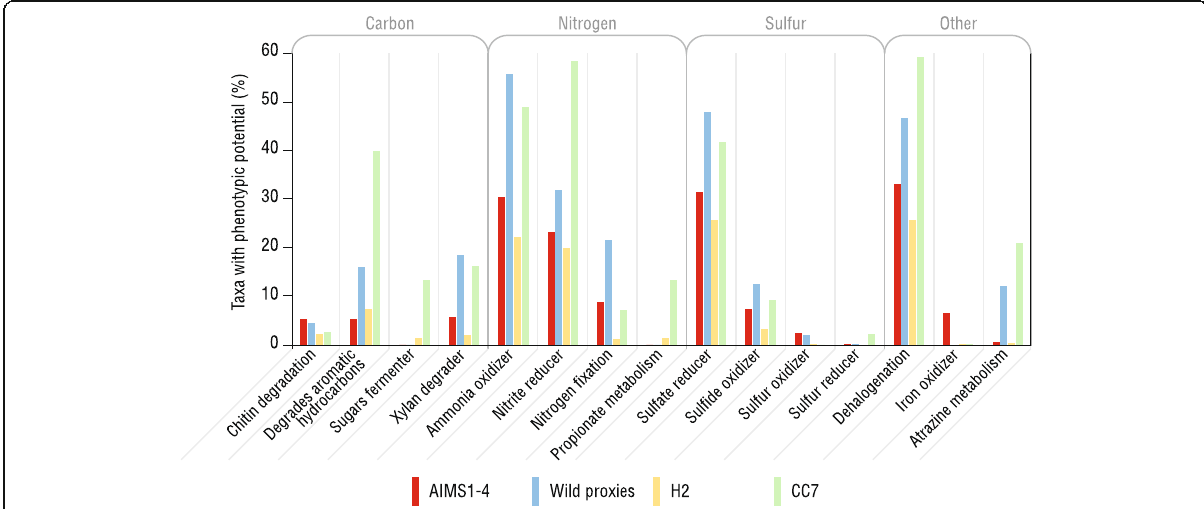
Fig. 6 Putative phenotypic potential of bacteria in each E. diaphana sample type. Vertical bars indicate the percentage of bacterial taxa in each sample type with the phenotypic potential for each metabolism category according to taxonomy-to-phenotype